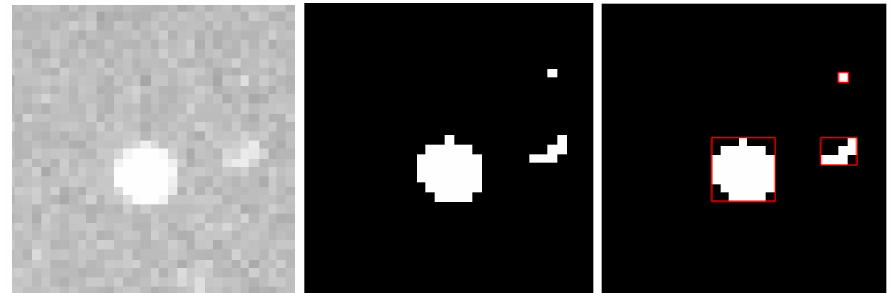
Figure 5. Process of finding the maximum target size in an image